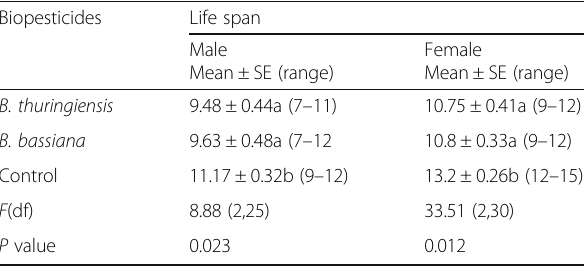
Table 4 Comparison of T. absoluta life span treated as second instar larvae by LC 50 values of B. thuringiensis or B. bassiana